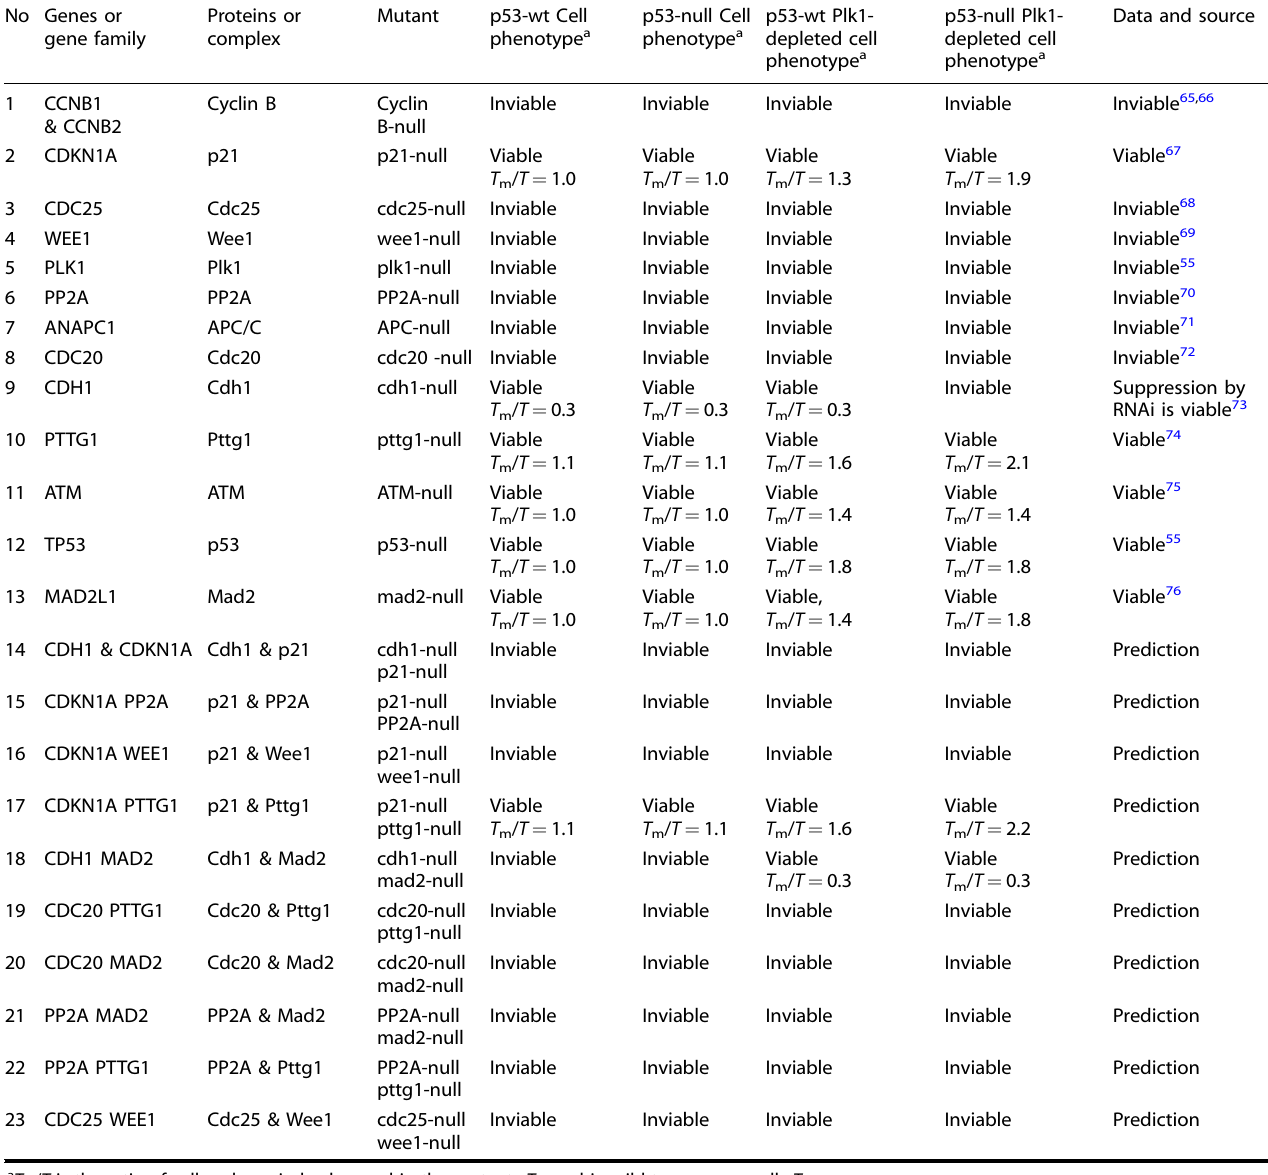
Table 1. Predicted phenotypes of some gene deletion mutants and comparison with data. No Genes or gene